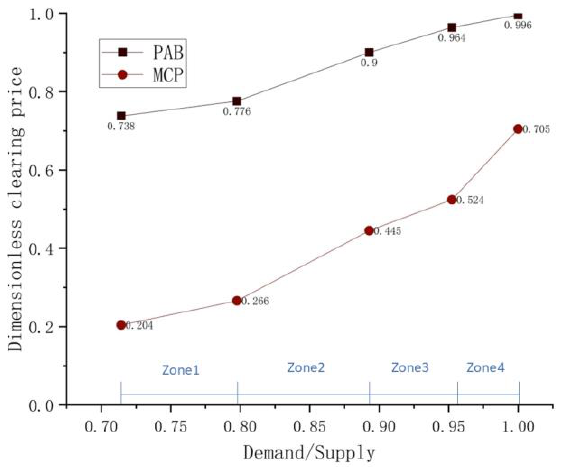
Figure 7. Variation in dimensionless supply/demand ratio and clearing price. Table 5. Slope of settlement price change under the influence of supply and demand.